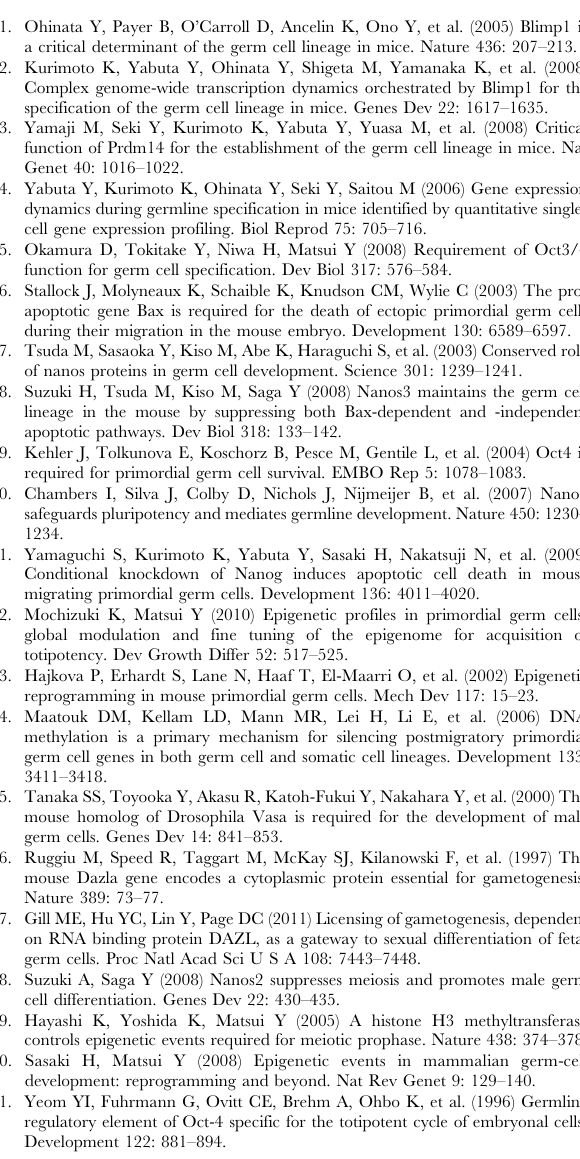
Figure S6 (A, B) Luciferase activities from the luciferase reporter vectors of the in vitro methylated or unmethylated regulatory region of mil-1 with C to T replacement of some CpG sites in ES cells (B). Number within parenthesis indicates positions of C to T replacement shown in (A). Luciferase activity was normalized against the activity of a co-transfected Renilla construct. The data were obtained from four independent experiments. *p , 0.05. Error bars represent SEM. Table S1 Primers used for bisulfite sequence analyses. Table S2 Primers used for quantitative PCR analyses of ChIP DNA.